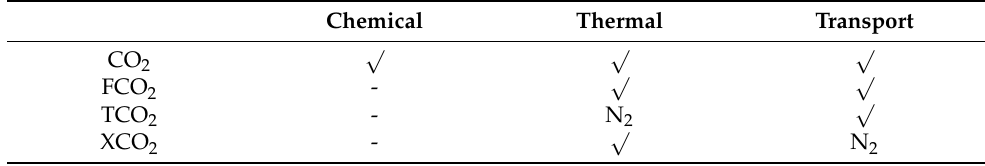
Table 1. The specific properties of the artificial